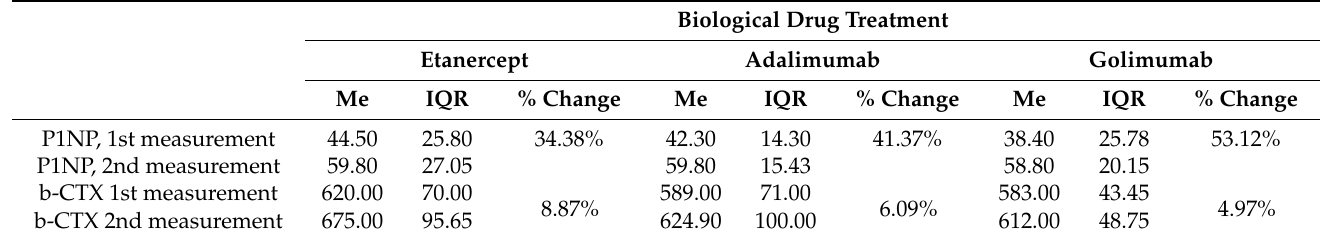
Table 4. Percentage change in P1NP and b-CTX with respect to the prescribed TNF